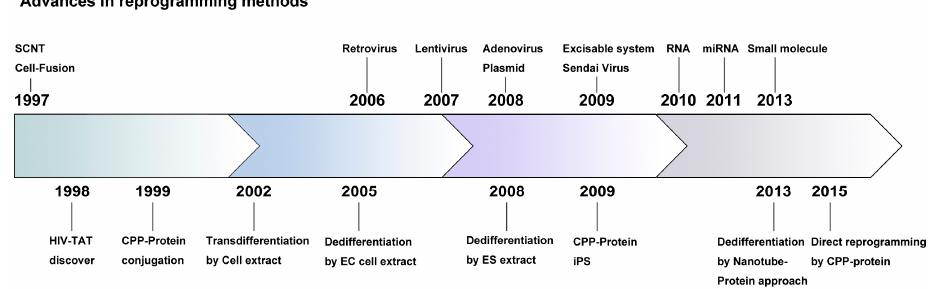
Figure 1. Timeline of reprogramming research. The upper panel represents advances in non-protein-based reprogramming approaches, while the bottom panel represents protein-based reprogramming approaches.